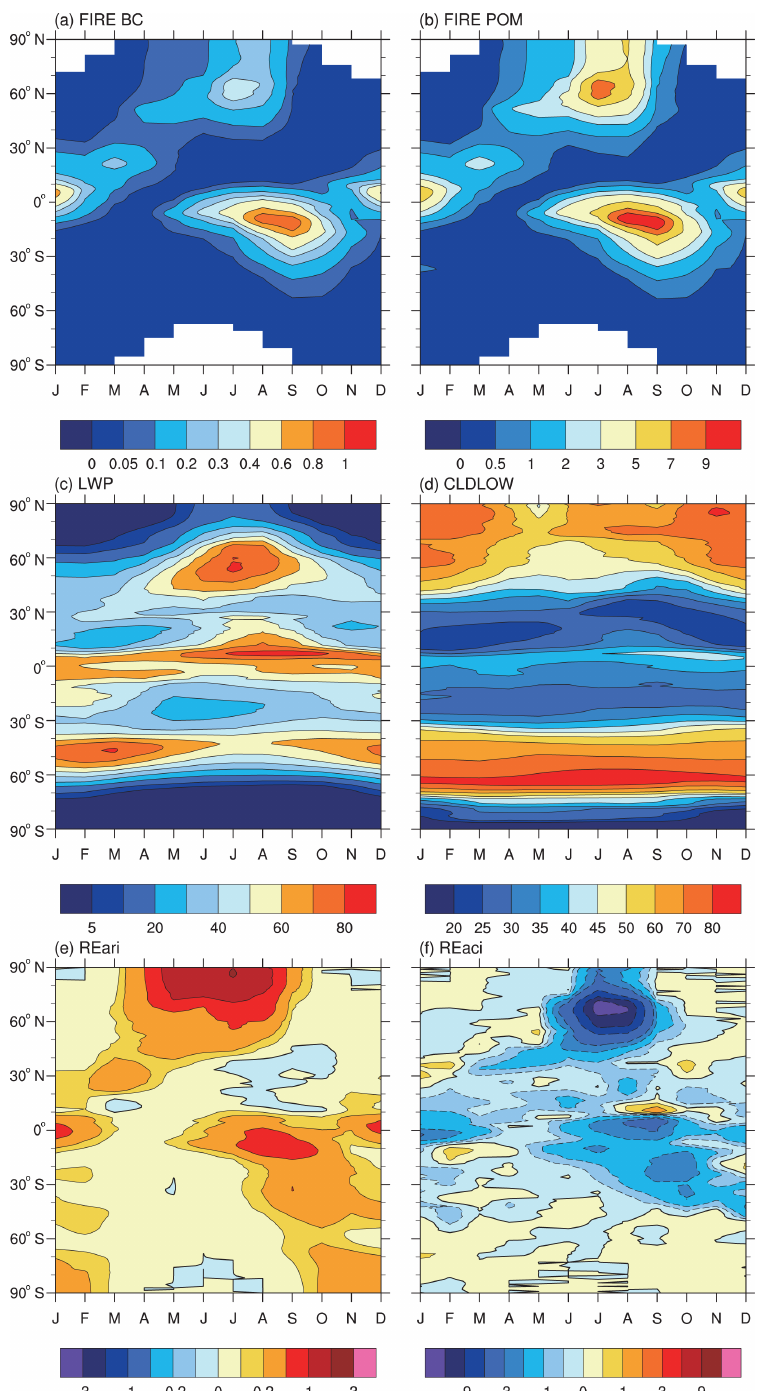
Figure 8. Time-latitude cross sections of zonal mean and monthly (a) vertically integrated concentrations (mgm − 2 ) of fire BC and (b) fire POM, (c) cloud liquid water path (LWP, in gm − 2 ) , (d) low-level cloud cover (CLDLOW, in %), (e) radiative effect due to aerosol–radiation interactions (REari, in Wm − 2 ) and (f) radiative effect due to aerosol–cloud interactions (REaci, in Wm − 2 ) of all fire